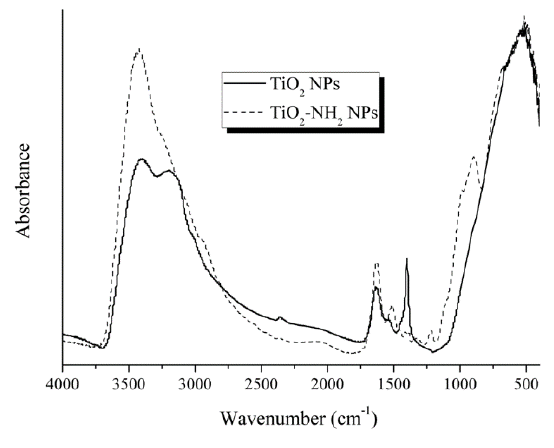
Figure 11. FTIR spectra of a-TiO 2 -based NPs.